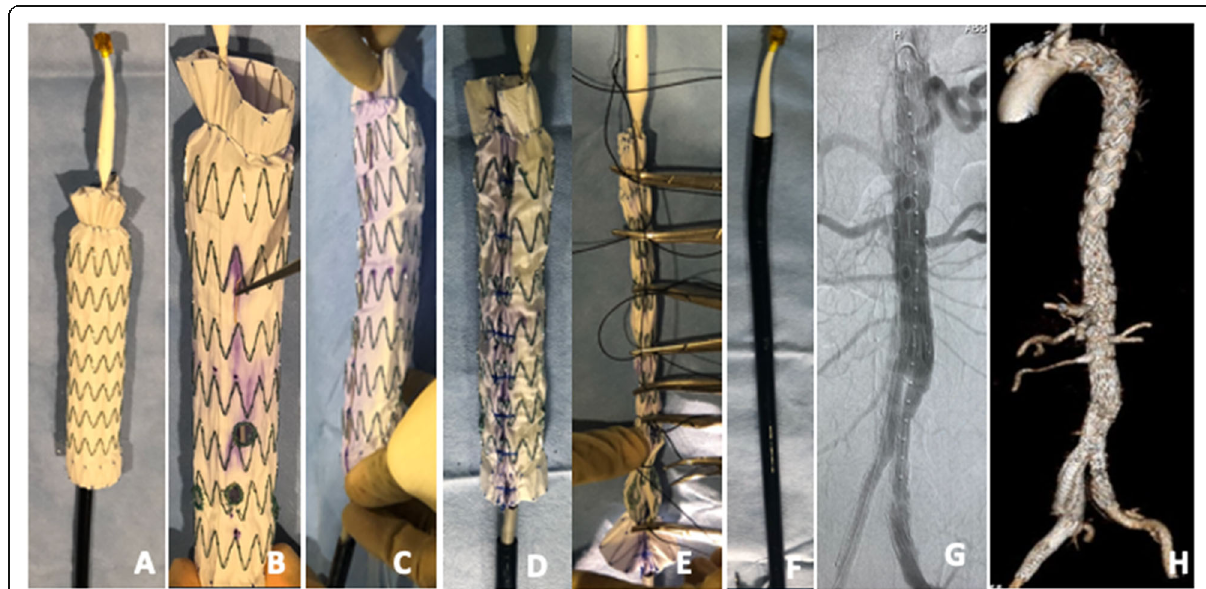
Fig. 3 Steps of modification of the Zenith TX2 Dissection Endovascular Graft with Pro-Form. The device is deployed on a sterile back Table ( A ). Creation and reinforcement of fenestrations are as described in Fig. 5B. Note the presence of an anterior marker (not yet sutured in place) which aids with device orientation ( B ). A long spinal needle is used to redirect one of the 3 nitinol wires removed from the inner cannula through and through the endograft fabric ( C ). T he device is constrained posteriorly at every Z stent as described in Figure legend 2C ( D ). The graft is collapsed using silk ties and resheathed ( E&F ). Completion angiography and post-operative 3D CTA showing exclusion of the aneurysm and patency of all 6 target vessels (celiac, SMA, 2 right renal arteries, 1 left renal artery, and right internal iliac artery) ( G&H ). Rationale for device selection : The Zenith TX2 double tapered (32 – 24-158) was chosen for its size and length (32 mm diameter into a 30 mm diameter existing graft and 158 cm long) to allow seal into the existing TEVAR with a minimum of 3 stent overlap while providing adequate room for creation of five fenestrations. The distal tapered (24 mm diameter) allowed for the use of a Zenith fenestrated universal bifurcated device we had available in our